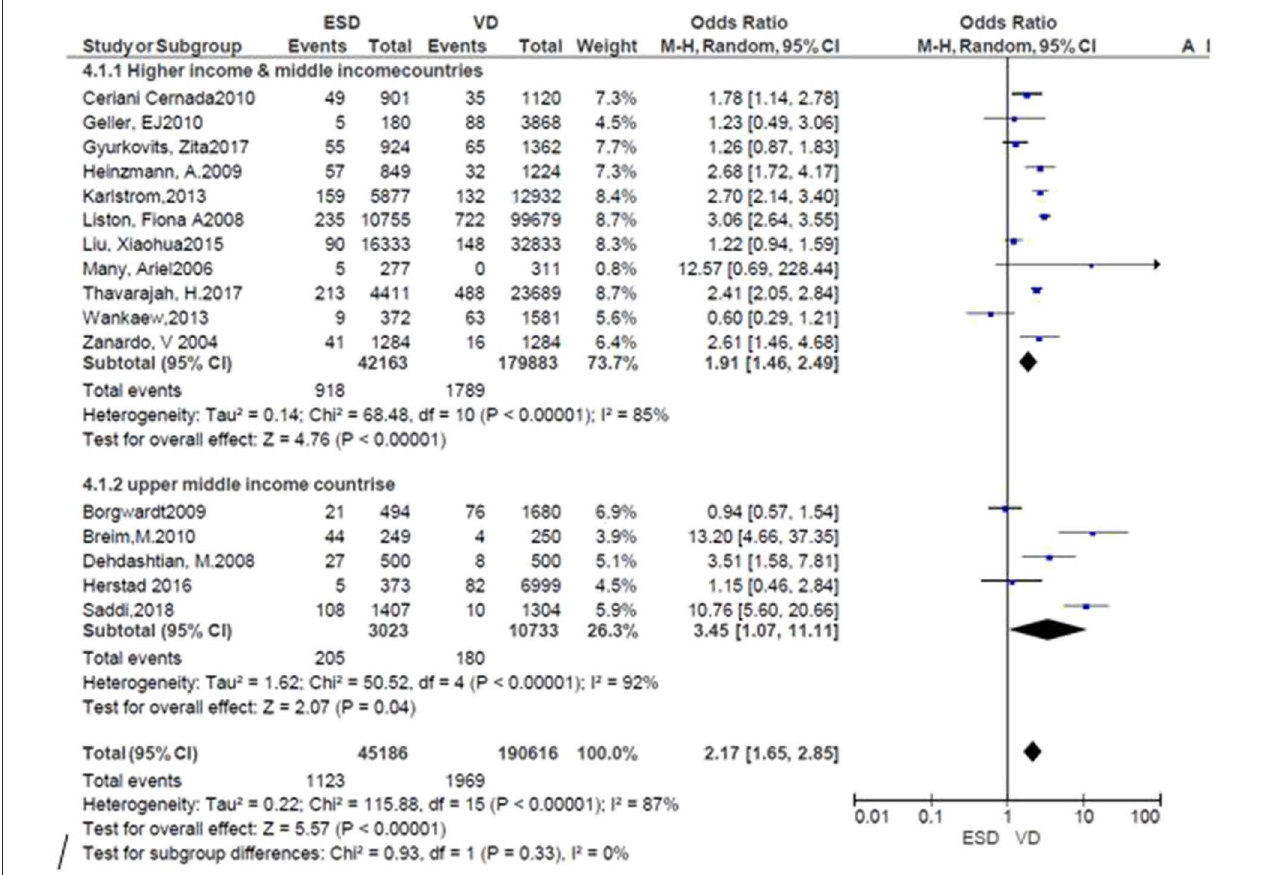
FIGURE 3 | Subgroup analysis; risk of neonatal respiratory morbidity in spontaneous vaginal delivery vs. elective cesarean section at upper-middle income and higher-income countries, 2019.